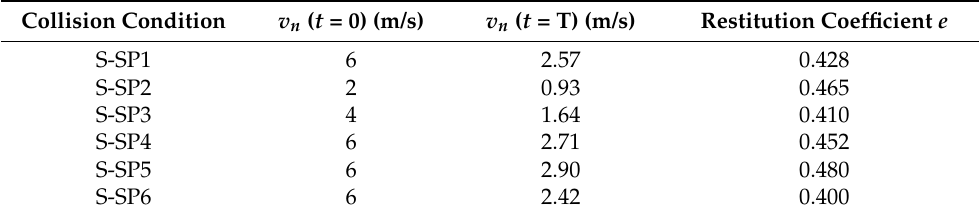
Table 8. The relative velocity before and after collision under various collision conditions. Collision